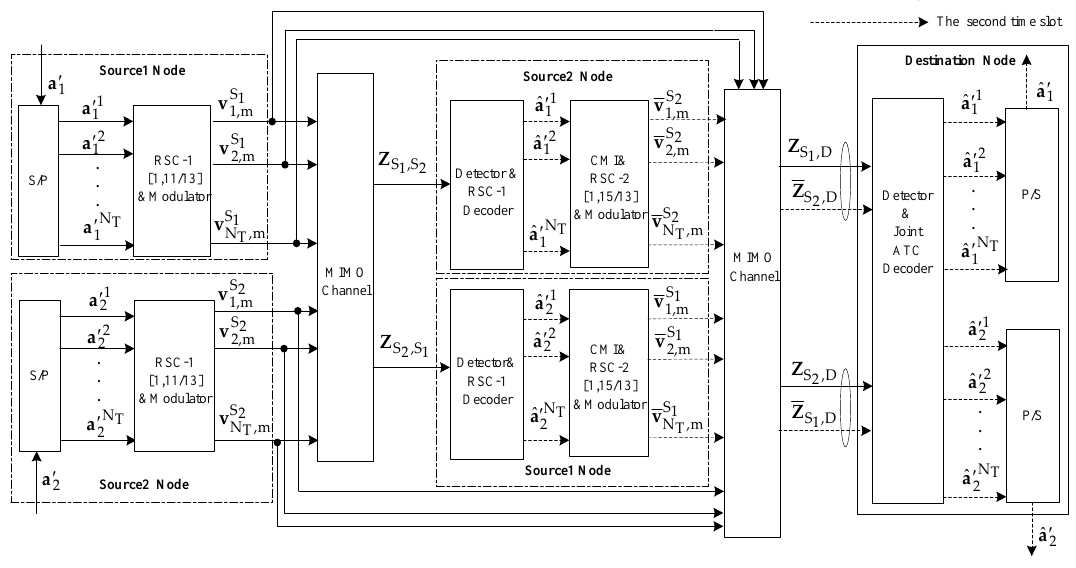
Figure 7. Two-source ATCC-VBLAST scheme with the CMI.